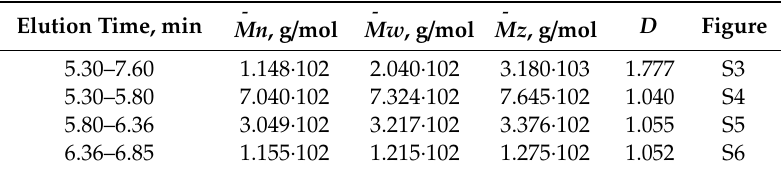
Table 3. Values of average molar mass ( M n), mass average molar mass ( M w), Z average molar mass ( M z), and polydispersity index ( D ) for irradiated liquid material from elugrams. Elution Time, min